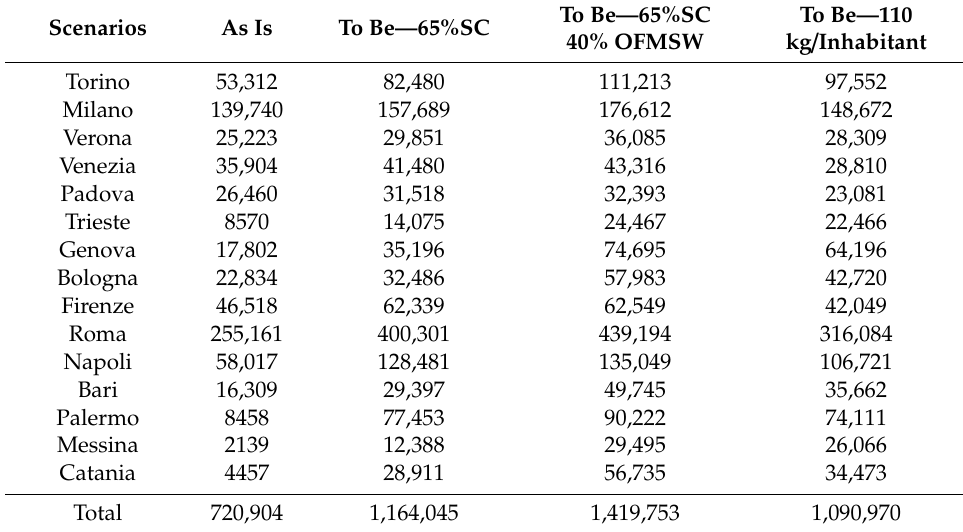
Table 7. Potential amount of the OFMSW conferred to biomethane plants